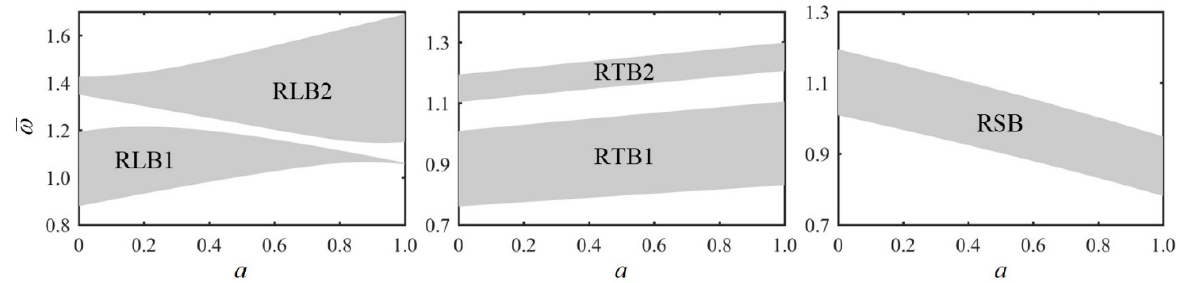
Figure 6. Variation of frequency bandgaps with anisotropic parameter a : longitudinal waves ( left ), transverse waves ( middle ), and in-plane shear waves ( right ).